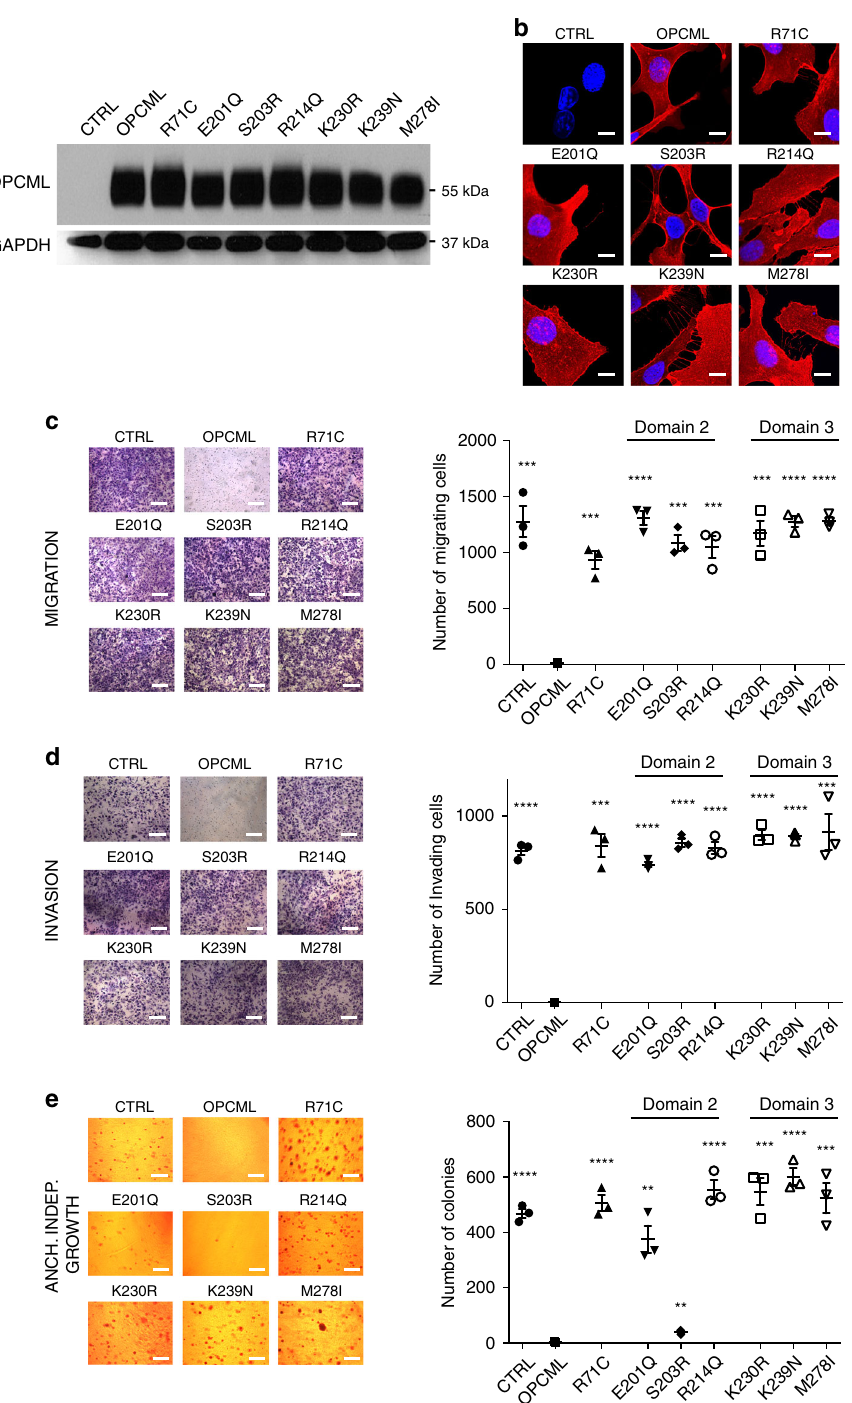
Fig. 6 Point mutations in D2 and D3 lead to loss of function. SKOV3 cells were transduced with an empty vector (CTRL), wild-type (OPCML) or mutant (R71C, E201Q, S203R, R214Q, K230R, K239N, M278I) OPCML and analyzed for protein expression by western blot ( a ) and protein expression/localization by confocal microscopy ( b ) with an anti-OPCML antibody. GAPDH was used as loading control in a . Scale bar = 5 μ m. Cells were then tested for migration ( c ) and invasion ( d ) in transwell assays and for anchorage-independent growth in agarose ( e ). Scale bar = 50 μ m ( c , d ) and 200 μ m ( e ). All the graphs show the mean ± s.e.m. of three independent experiments. Student t -test compares CTRL and mutants to wild-type OPCML: ** p < 0.01, *** p < 0.001, **** p < suppressor phenotype was not due to the stability of the homodimeric in solution, as shown by SEC-MALLS and gel fi l- molecule. tration. In addition, this protein reached the plasma membrane Despite the different chemical nature of the substitutions (to in cells, and the secreted recombinant protein had a melting Ser, Arg, or Leu), the disruptive effect of all three mutations was temperature similar to WT, indicating that the loss of tumor